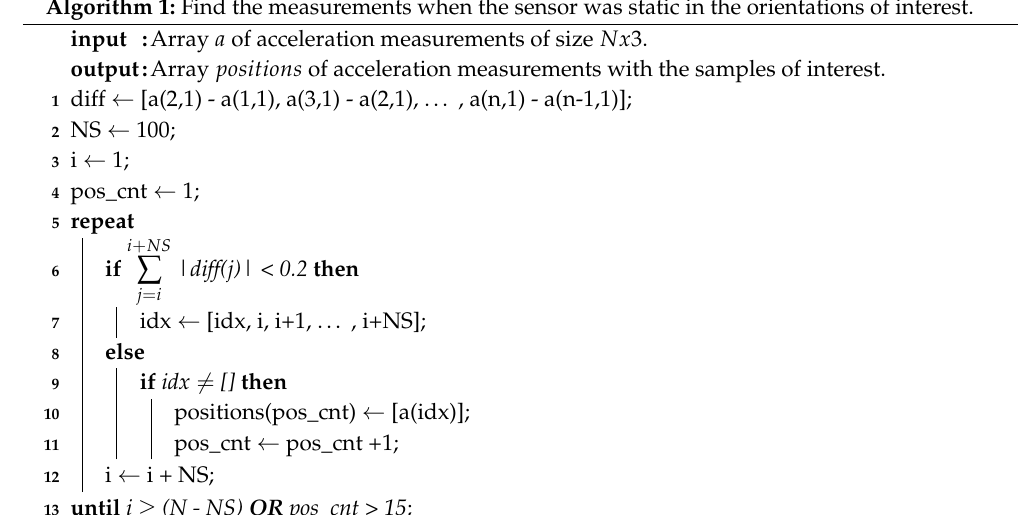
Algorithm 1: Find the measurements when the sensor was static in the orientations of interest.